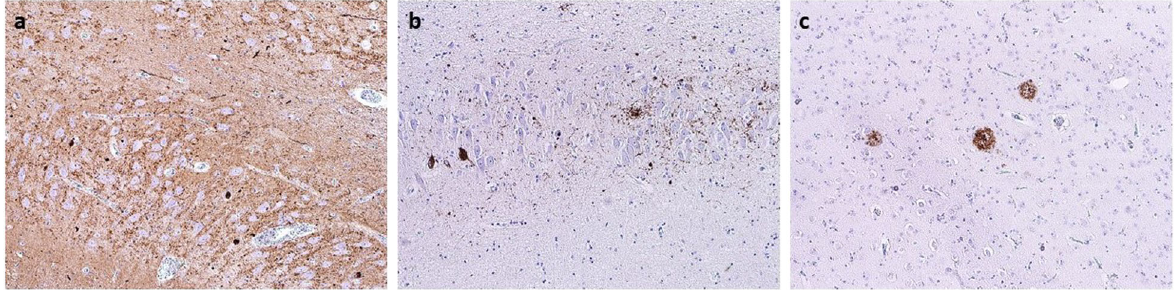
Fig. 3 “ Triple-pathology “ : α -synucleinopathy + tauopathy + β -amyloid in progressive supranuclear palsy — parkinsonism (PSP-P) phenotype. a Pathological deposits of α -synuclein in the hippocampus — Lewy bodies, dystrophic neurites, and dots, stained with a monoclonal antibody against α -synuclein, original magni fi cation ×100. b Pathological deposits of tau protein in the hippocampus — pretangles, threads, and grains, stained with a monoclonal antibody against hyperphosphorylated tau, original magni fi cation ×100. c Amyloid plaques in hippocampus positive in immunohistochemical reaction with a monoclonal antibody against amyloid- β -peptide, original magni fi cation